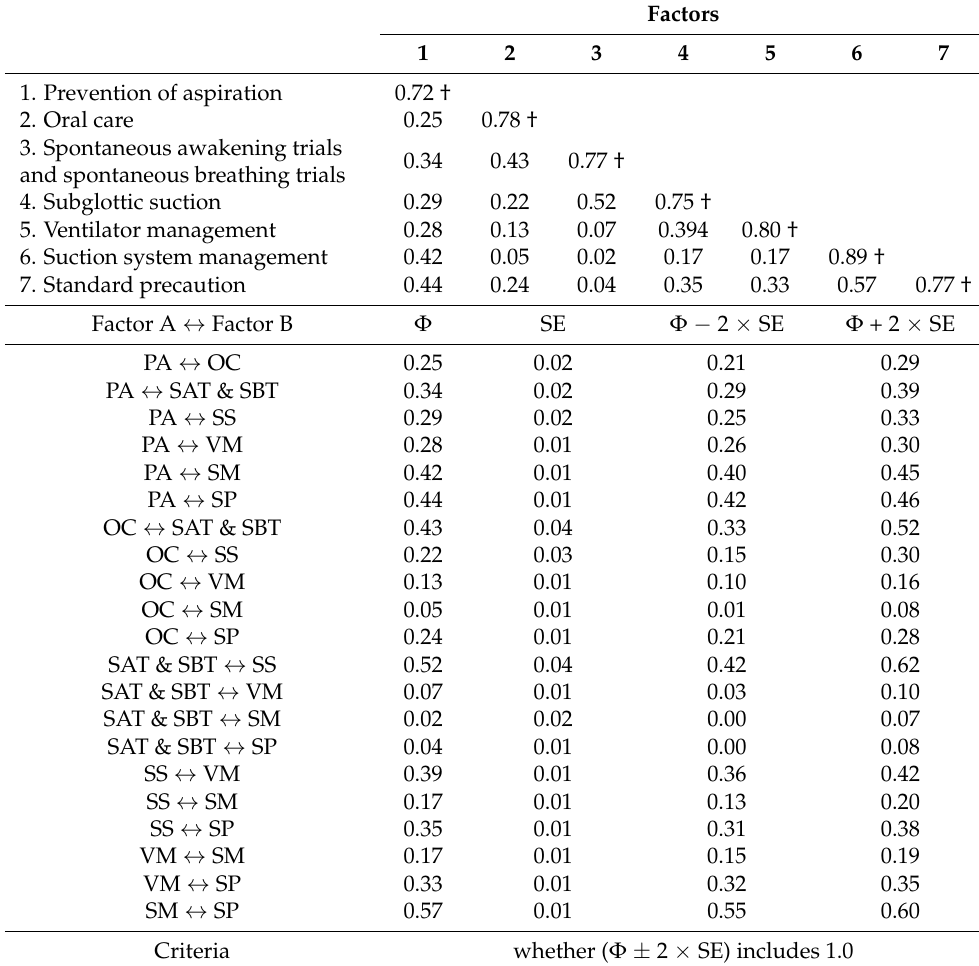
Table 4. Convergent and discriminant validity